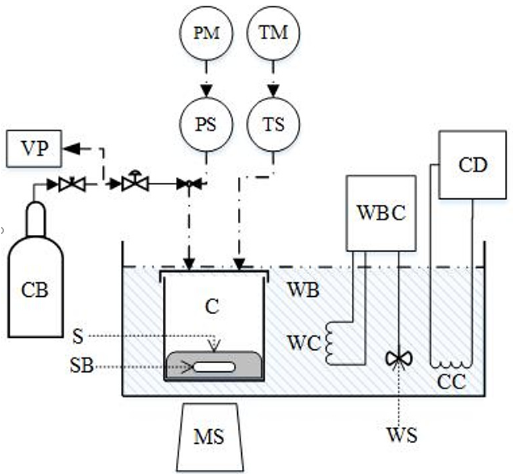
Figure 2. Experimental apparatus for VLE measurements consisting of: equilibrium cell (C), solution (S) weighted CO 2 flask (CB), cooling coil (CC), cooling device (CD), magnetic stirrer (MS), pressure indicator (PM), pressure sensor (PS), stirring bar (SB), temperature indicator (TM), Pt-100 thermometer (TS), vacuum pump (VP), water bath (WB), temperature controller/heater (WBC), heating coil (WC), and stirrer (WS). Reproduced from [23], with permission from